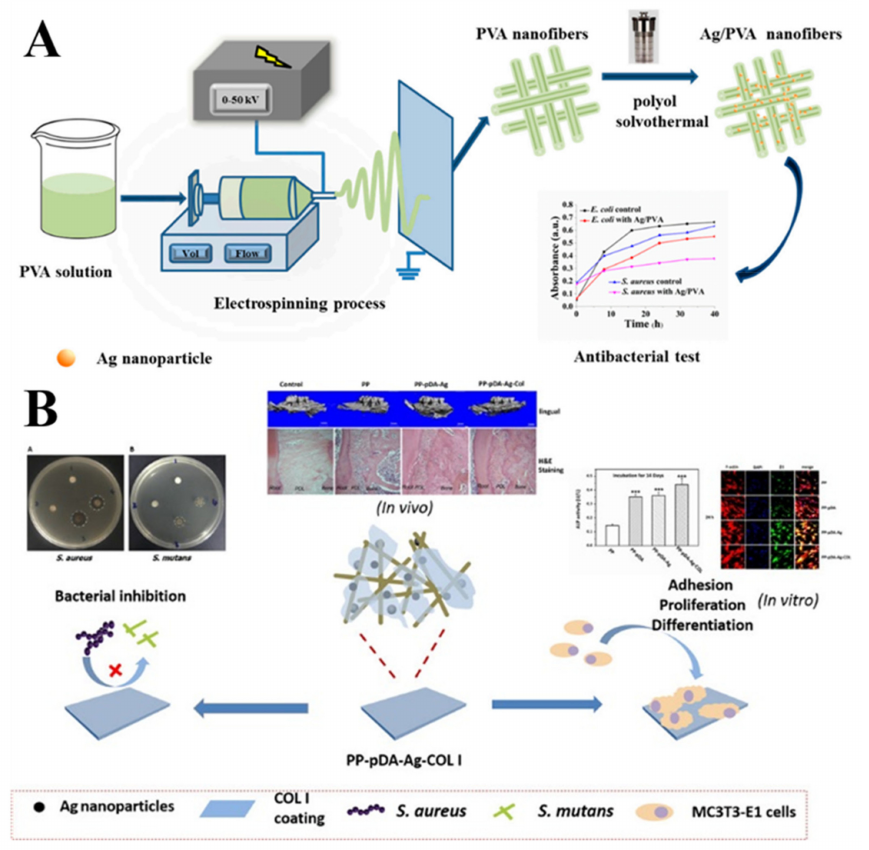
Figure 8. ( A ) Schematic illustration of fabrication and antibacterial test for Ag/PVA composite nanofibers through the electrospinning and solvothermal methods [82]. Copyright 2020 by the authors. ( B ) Triple PLGA/PCL scaffold modification including silver impregnation, collagen coating and electrospinning significantly improve biocompatibility, antimicrobial and osteogenic properties for orofacial tissue regeneration [85]. Copyright 2019 American Chemical